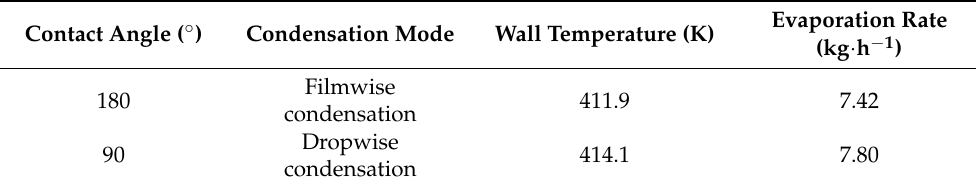
Table 4. Comparison of the equivalent evaporation rates between filmwise condensation and drop- wise